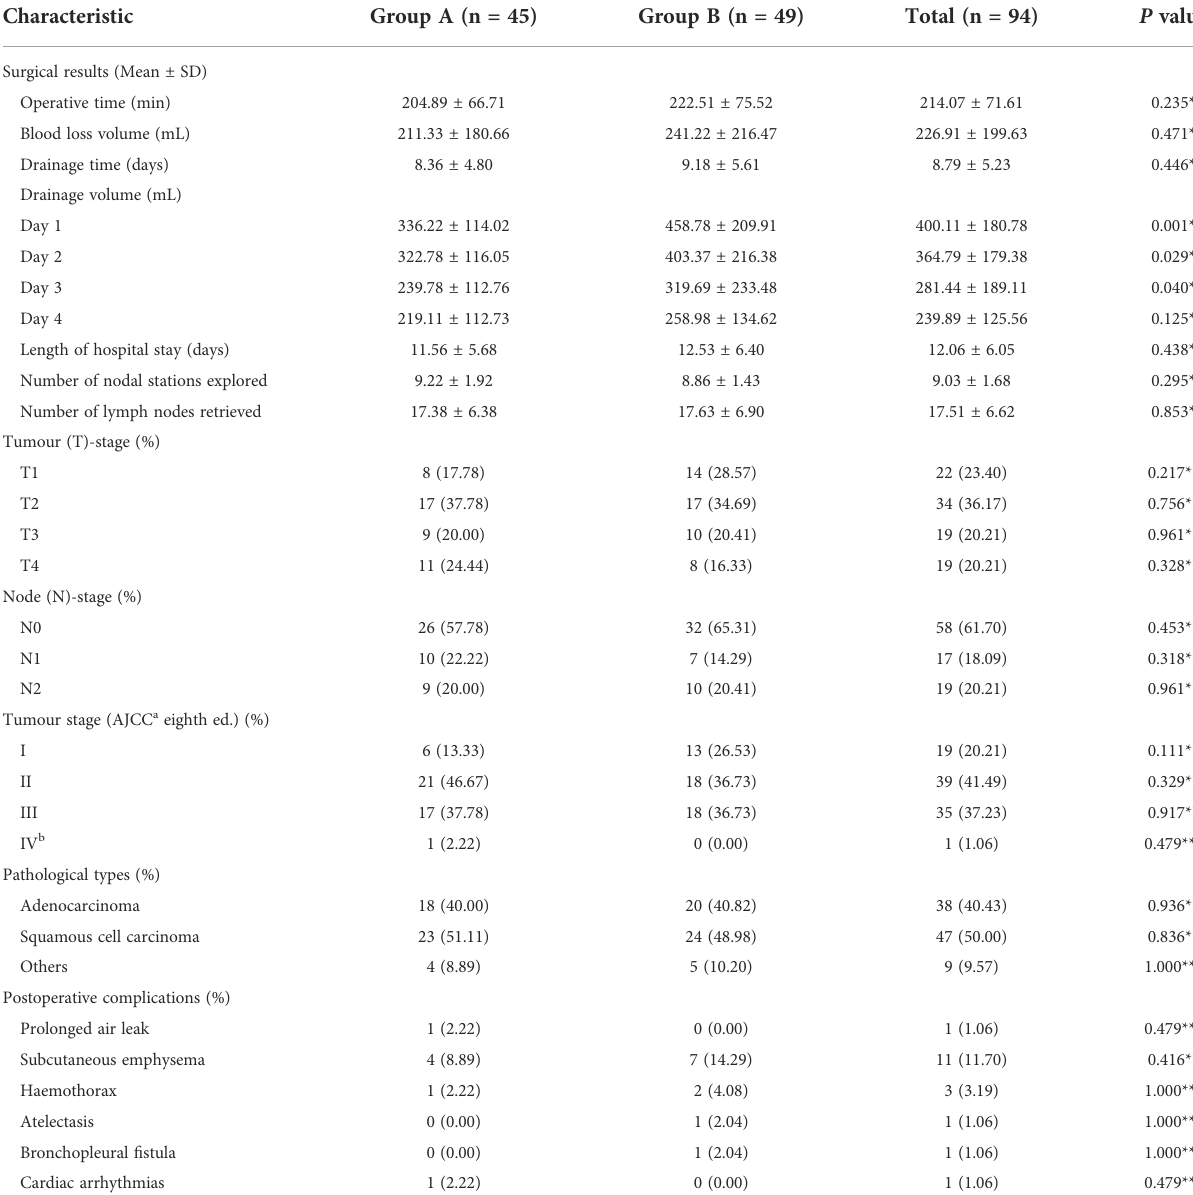
TABLE 2 Perioperative results. Characteristic Group A (n = 45) Group B (n = 49) Total (n =